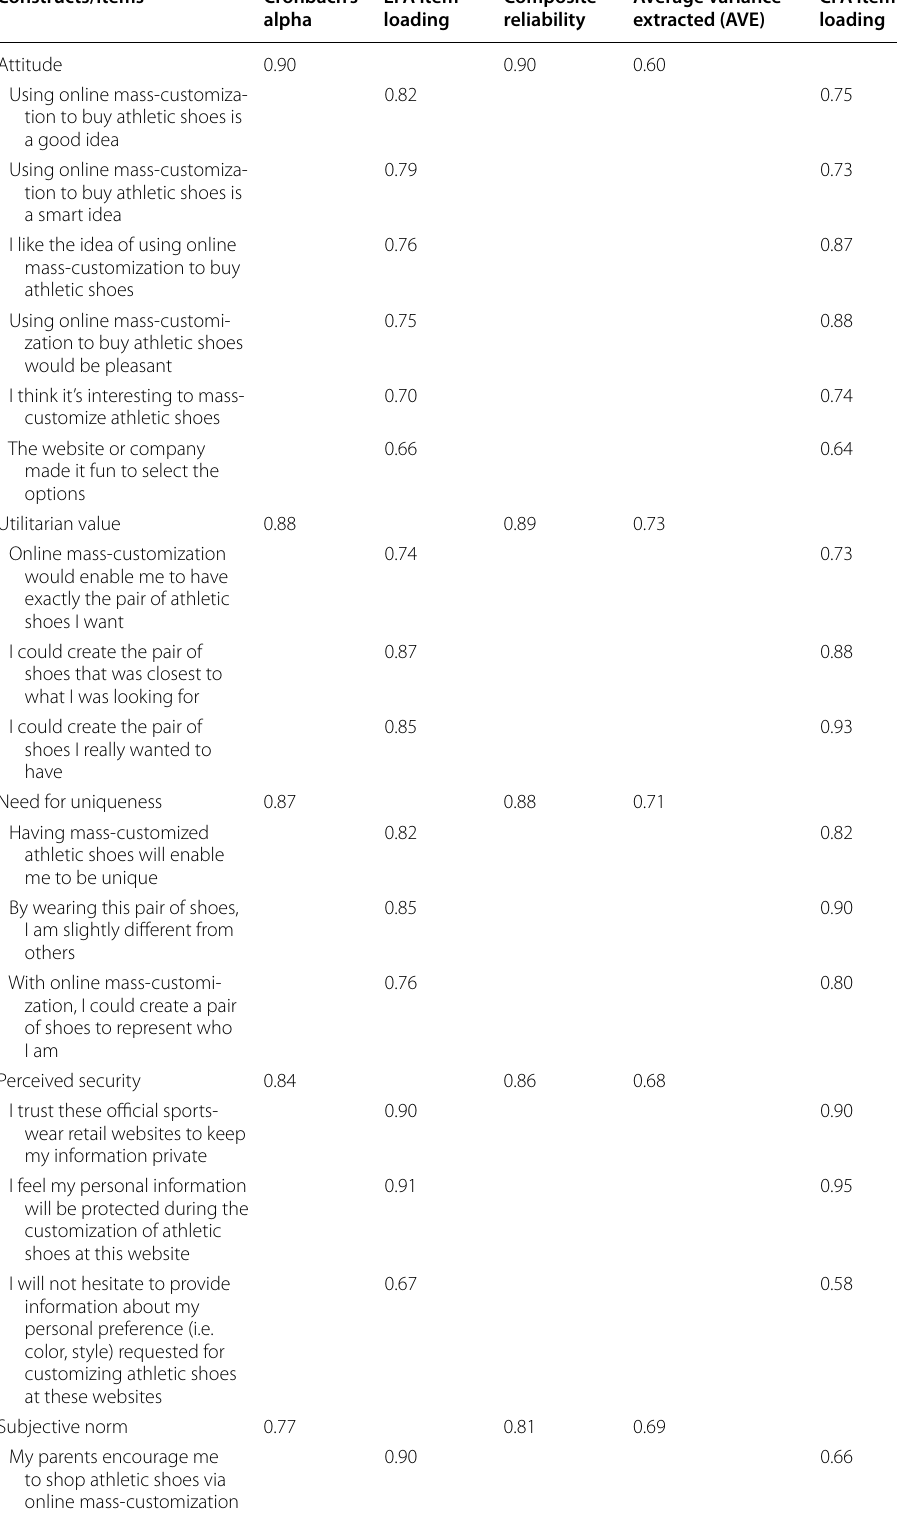
Table 2 Measurement model